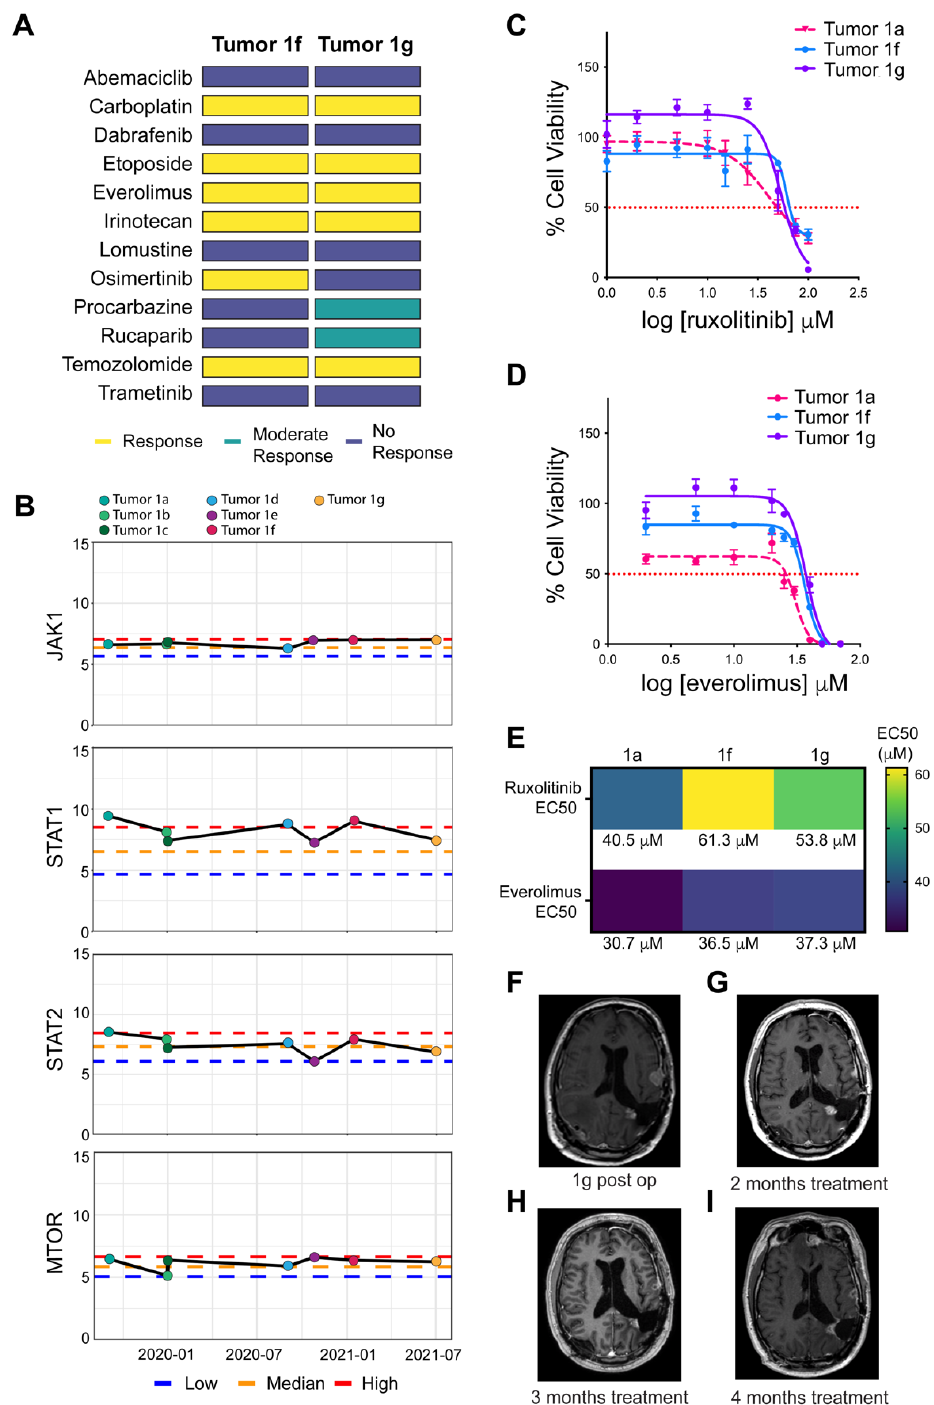
Figure 6. Patient 1 was found to benefit from a combination of JAK/STAT and mTOR inhibition. ( A ) 3D ‐ PREDICT response panels for tumors 1f and 1g. Yellow indicates drug response, teal indicates moderate drug response, and dark blue indicates no drug response. ( B ) Graphs of longitudinal log2(TPM+1) gene expression analysis of JAK1, STAT1, STAT2, and mTOR of all LFS patient tumors 1a ‐ 1g (color ‐ coded in key above graphs). Gene expression was recorded relative to the UAMS GBM compendium and was plotted as either low, median, or high expression. Dose ‐ response graphs of index (1a) and recurrent (1f and 1g) patient ‐ derived organoids were generated. Percent viability was plotted over the log of ruxolitinib ( C ) or everolimus ( D ) concentration to generate EC50 values for each tumor. The red dotted line indicates 50% viability. Each patient ‐ derived organoid drug screen